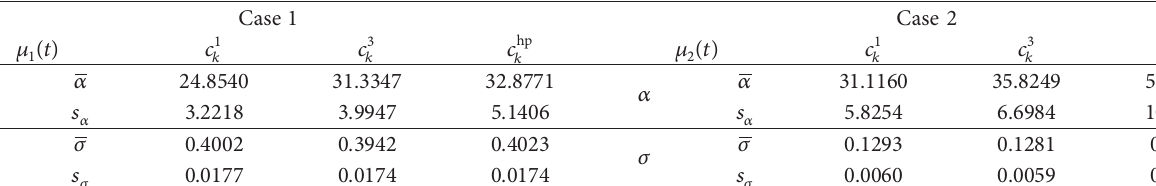
Table 2: Results obtained with 1000 simulations with 250 observations each. The real values of the parameters are shown in Table 1. For case 1 in the convolutions we use 𝑁 = 22 and for case 2 𝑁 = 60 . For both cases we set 𝜆 = 62500 in 𝑐 hp 𝑘 .